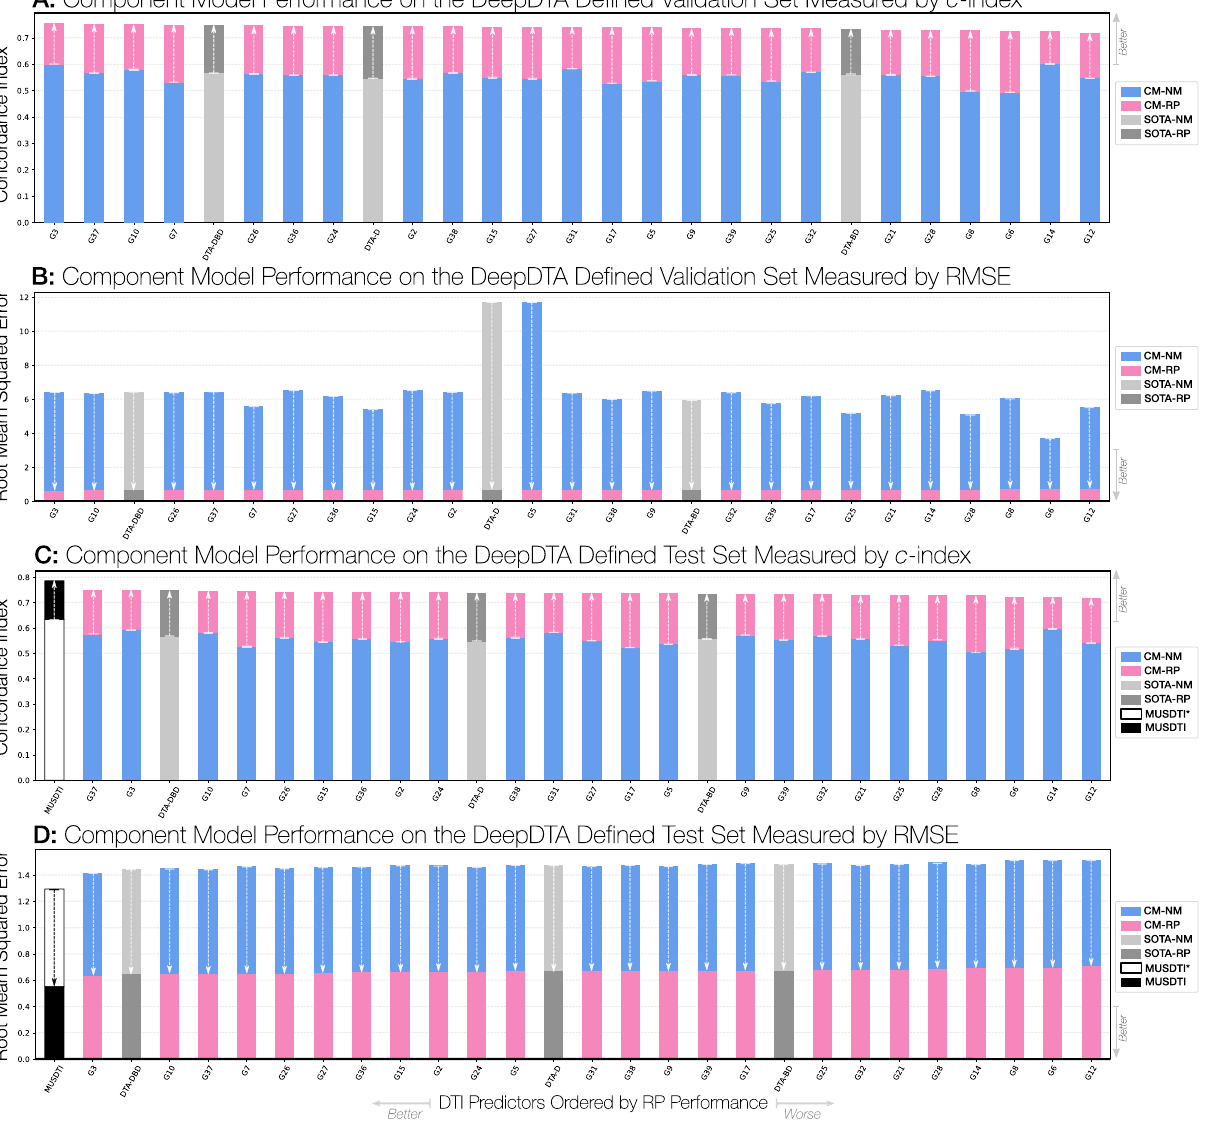
Figure 6. Component model performance improvement from the reciprocal perspective cascaded layer over the DeepDTA-defined